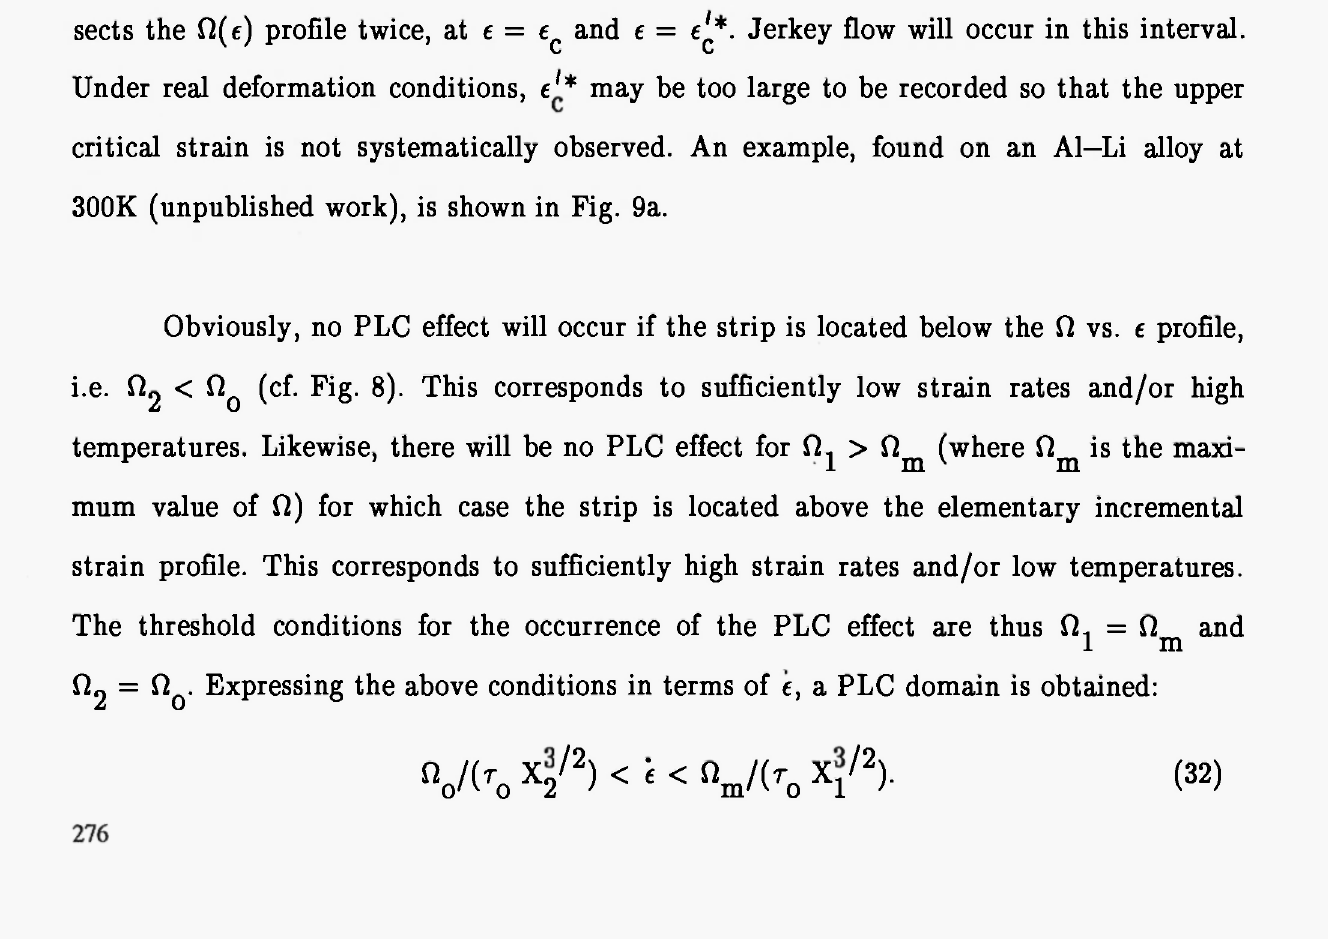
Ω„,, and Ω denote 0) β . The lower (e ) 2 c